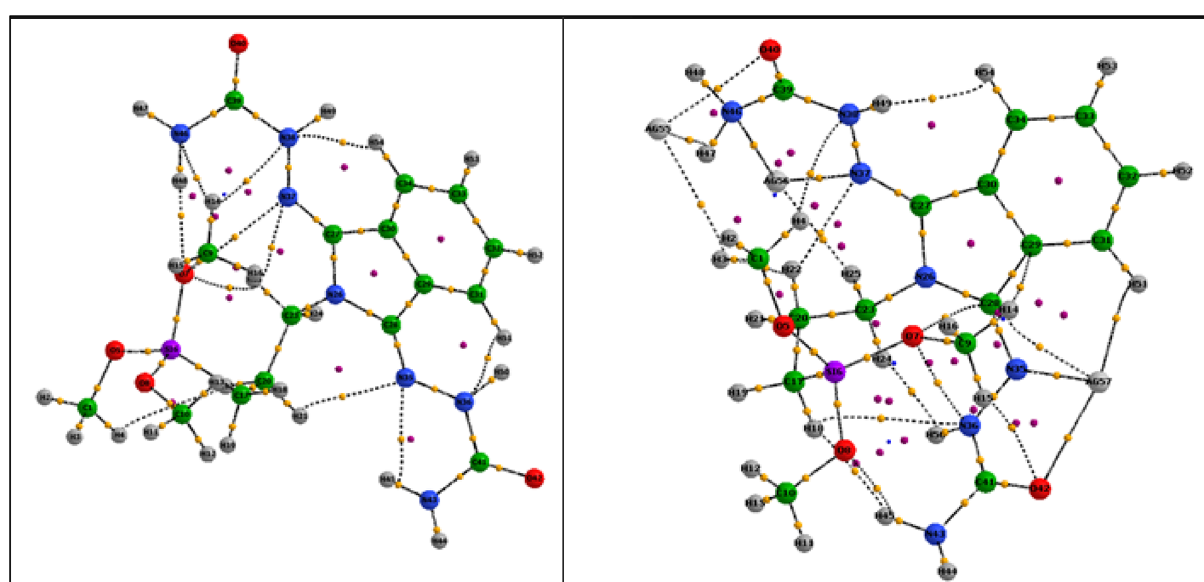
Figure 3. QTAIM graphs of n-HA/Si-PA-SC ligand and n-HA/Si-PA-SC-Ag complex model, obtained by the analysis of M06/6-311G** electron density functions. Bond Critical Points: yellow circles; Ring Critical Points: purple circles; Bond Paths: black